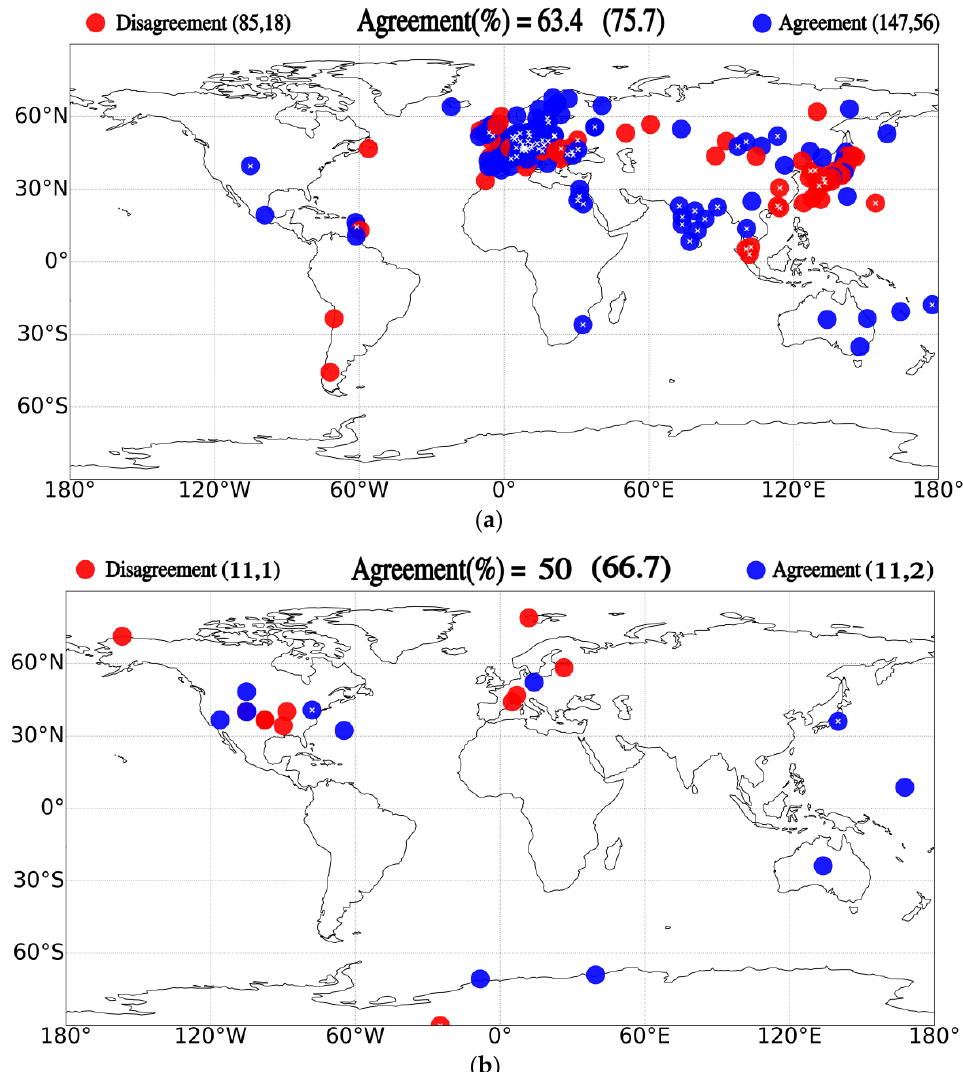
Figure 9. Agreement (blue dots) and disagreement (red dots) between trends of MERRA-2 and station deseasonalized SSR anomalies for GEBA ( a ) and BSRN ( b ) stations. The embedded white “x” symbols indicate the statistically significant trends for both MERRA-2 and stations. At the top left and top right parts above each panel figure, the numbers in parentheses provide the total number of stations for which there is agreement/disagreement (first number in parentheses) and the corresponding numbers for statistically significant trends (second number in parentheses). At the top center of each panel figure, the percent numbers of stations for which agreement, as well as those for which statistically significant agreement (in parenthesis), is found, are given.